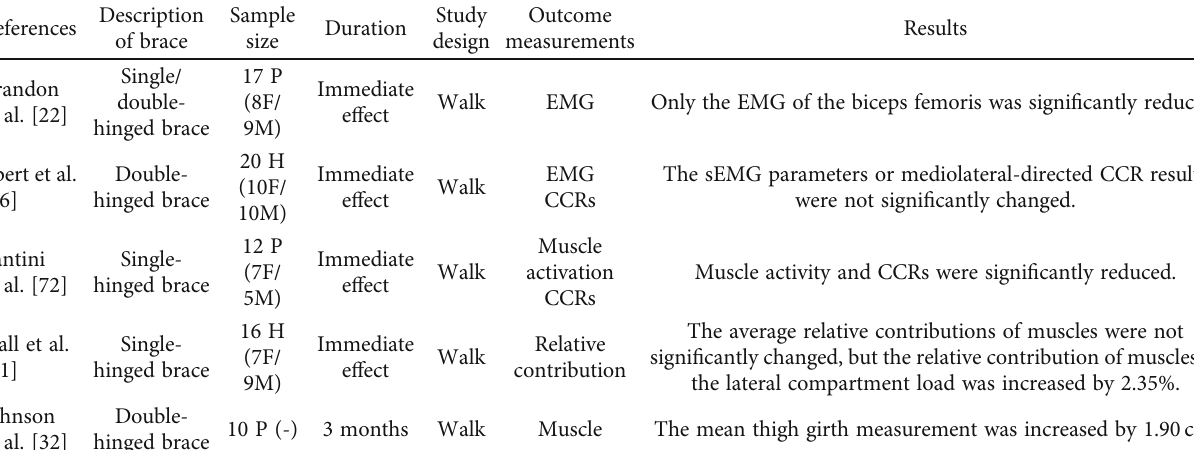
Table 6: Studies that evaluated the e ff ect of knee brace on muscle in medial gonarthrosis. Description References of